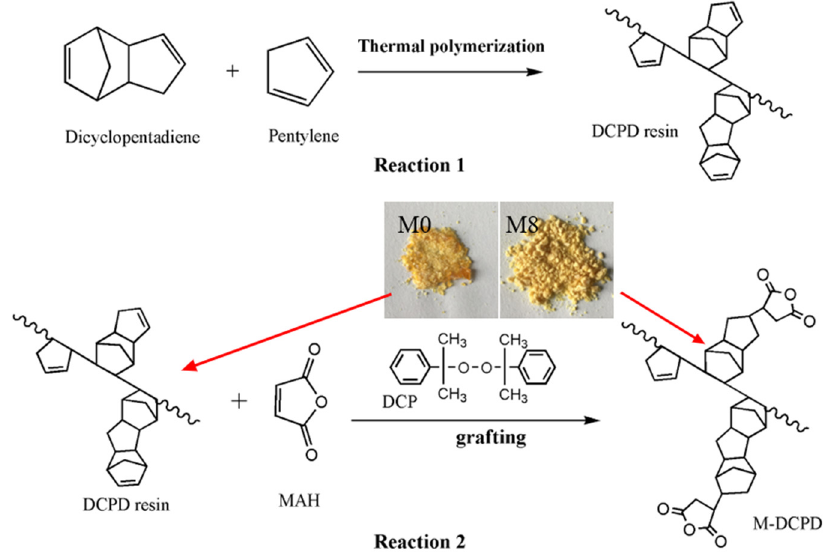
Figure 1. Reaction 1 refers to the diagram described preparation of dicyclopentadiene (DCPD) resin; reaction 2 refers to the preparation of modified DCPD resin. Table 1. The dosages of synthetic ingredients.